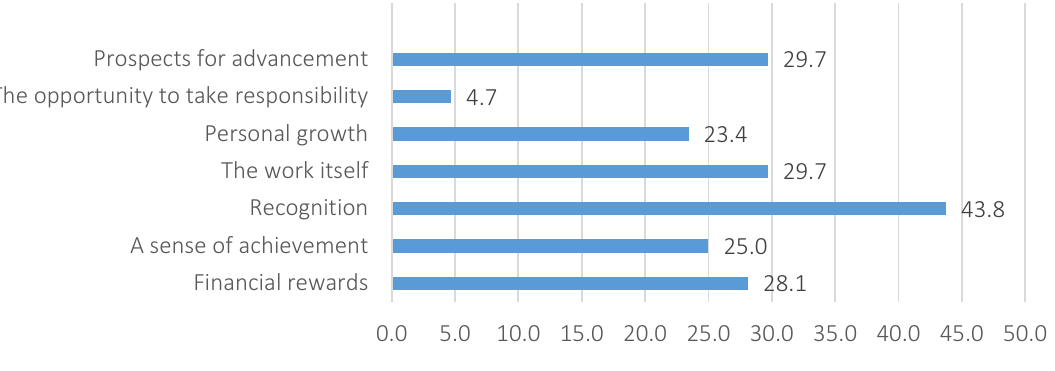
Figure 1. Herzberg’s sources of satisfaction (motivators) vs. financial rewards (%) Table 2. Two proportion z - test to compare financial rewards with Herzberg’s motivators ( p -values)